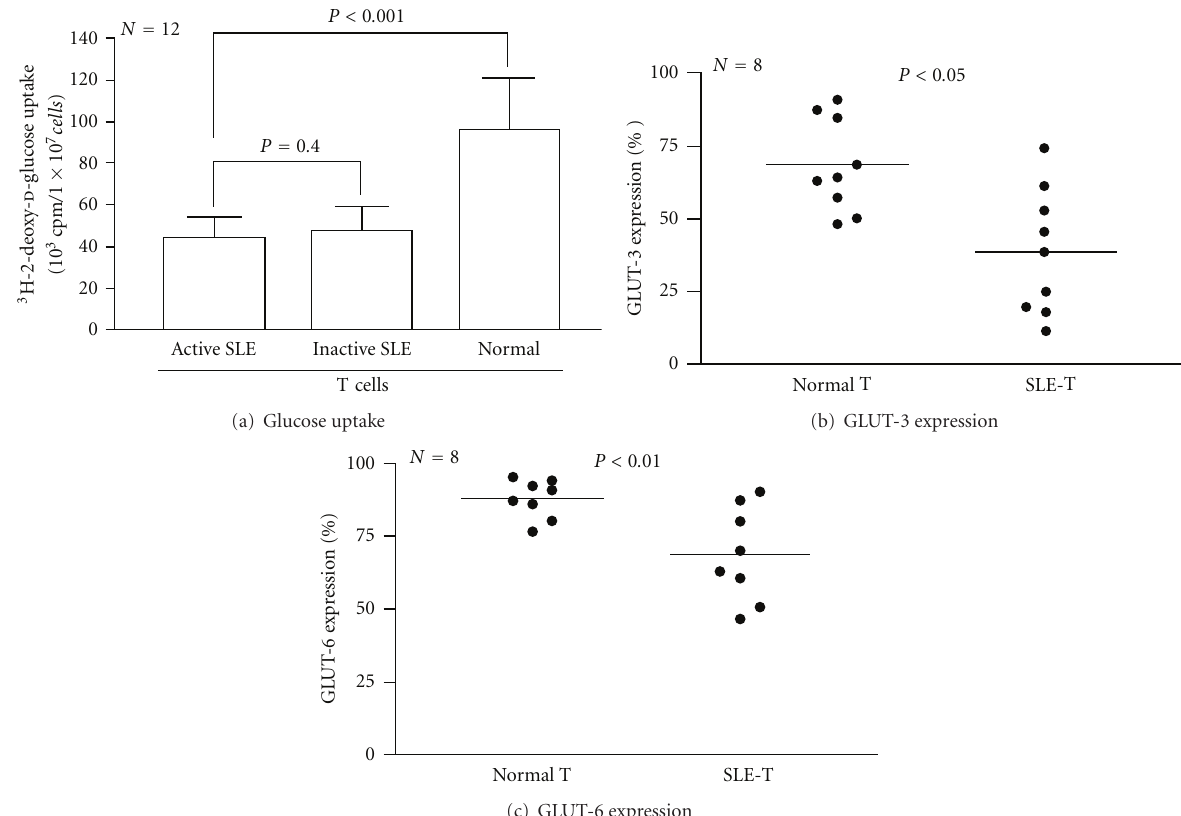
Figure 2: Comparison of glucose uptake and expression of glucose transporter type 3 (GLUT-3) and type 6 (GLUT-6) on T lymphocytes in normal and active SLE groups. (a) Glucose uptake by the cells detected by 3 H-2-deoxy- d -glucose incorporation after 24-hour incubation. (b) Expression of GLUT-3 on normal and active SLE T lymphocytes. (c) Expression of GLUT-6 on normal and active SLE T